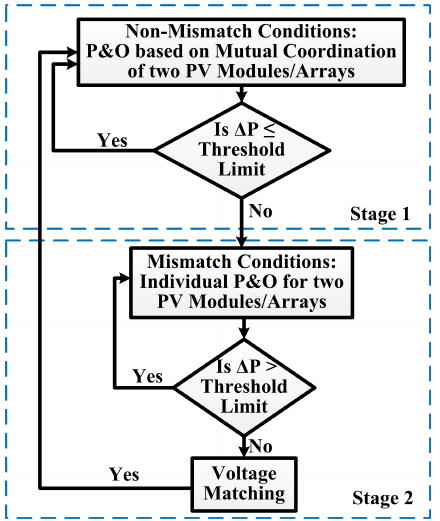
Figure 3. Basic scheme of proposed